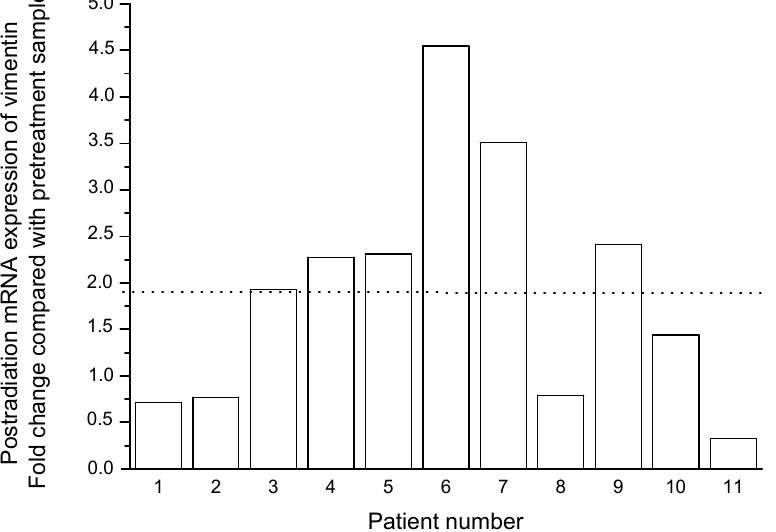
Figure 9. Individual changes in mRNA expression of vimentin in cervical scrapings from 11 CC patients 24 h after radiation exposure at a TD of 10 Gy. The dotted line indicates the mean value of the changes.